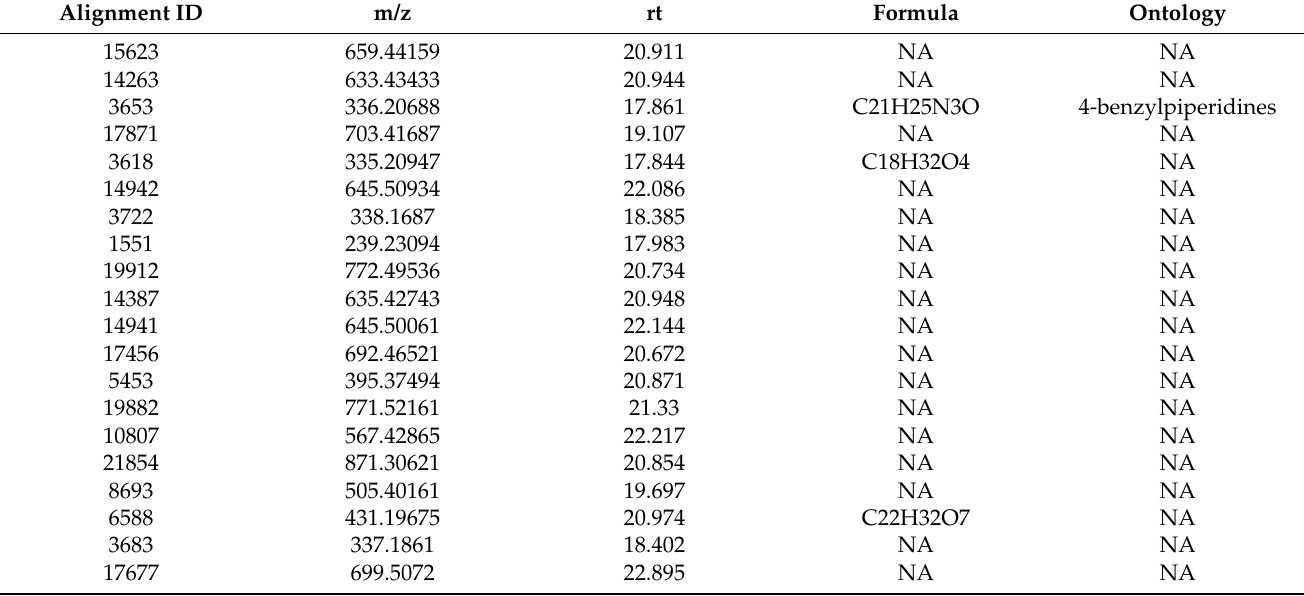
Table 2. Suggested compounds in F15-17 subfractions from MetaboAnalyst and MS-DIAL. Formula